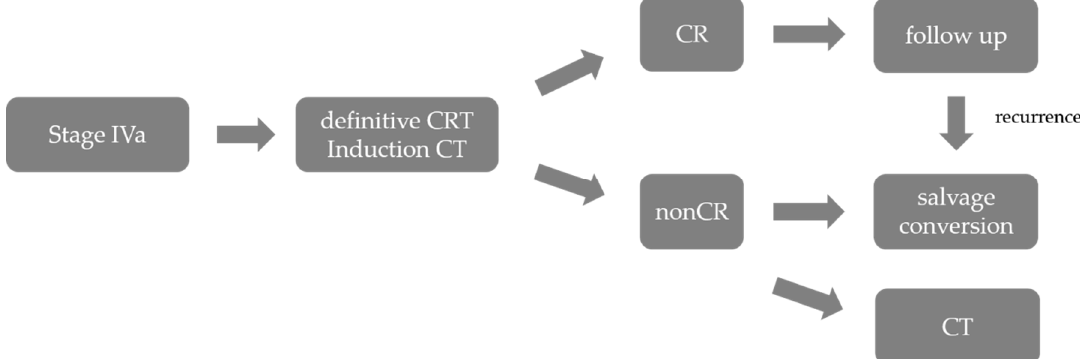
Figure 2. Treatment strategies for stage IVa ESCC, adapted and modified from guidelines of the Japan Esophageal Society. ESCC, esophageal squamous cell carcinoma; CRT, chemoradiotherapy; CT, chemotherapy; CR complete response.